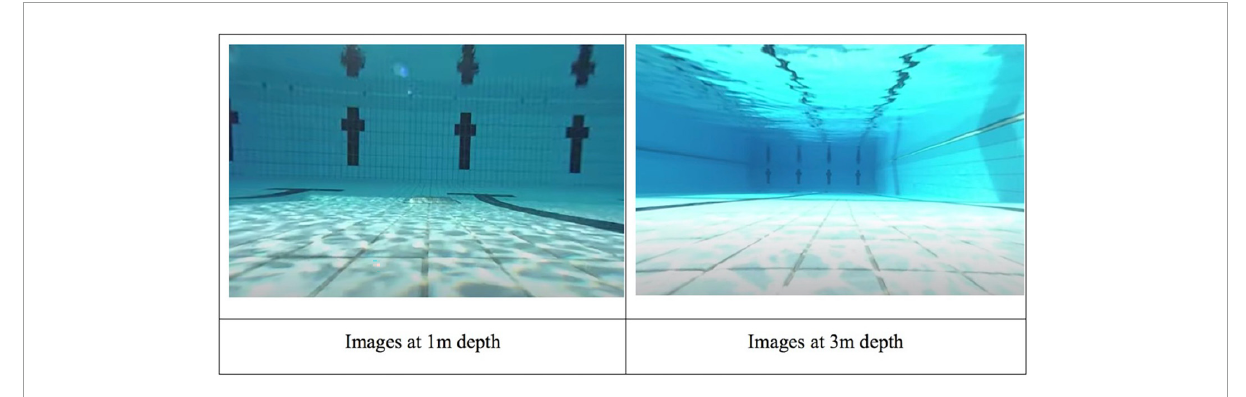
FIGURE2 Videos from HMD for immersive viewing situations.